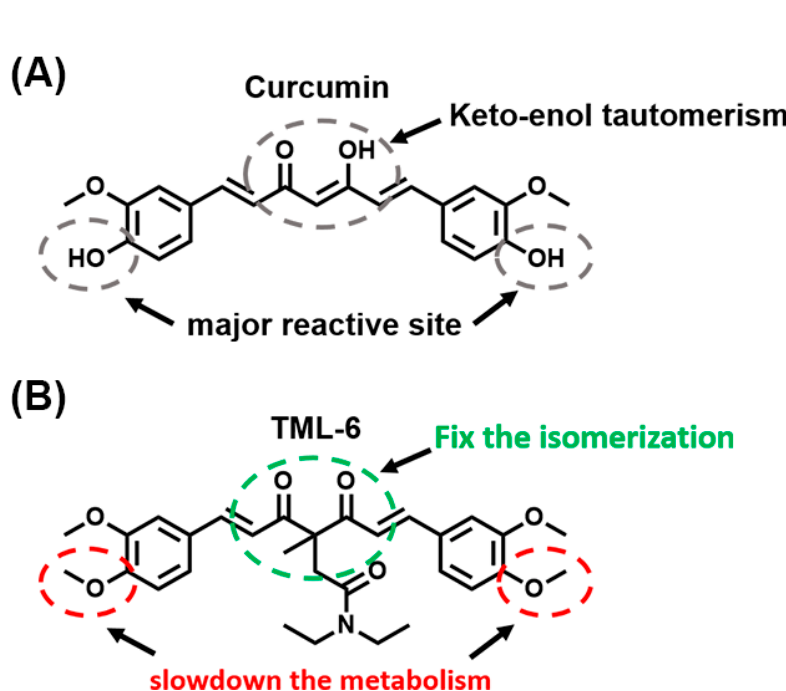
Figure 1. Comparison of traditional curcumin and TML-6 through its chemical structure. ( A ) The medical use of traditional curcumin is limited by its water insolubility (hydrophobic), low intestinal absorption, rapid metabolism, which leads to poor bioavailability. ( B ) TML-6 modified from traditional curcumin conserves the bioactivity of curcumin, becomes more stable, and slows down in metabolism. However, preliminary studies revealed that both curcumin and TML-6 had poor water solubility and need to be optimized by formulation.